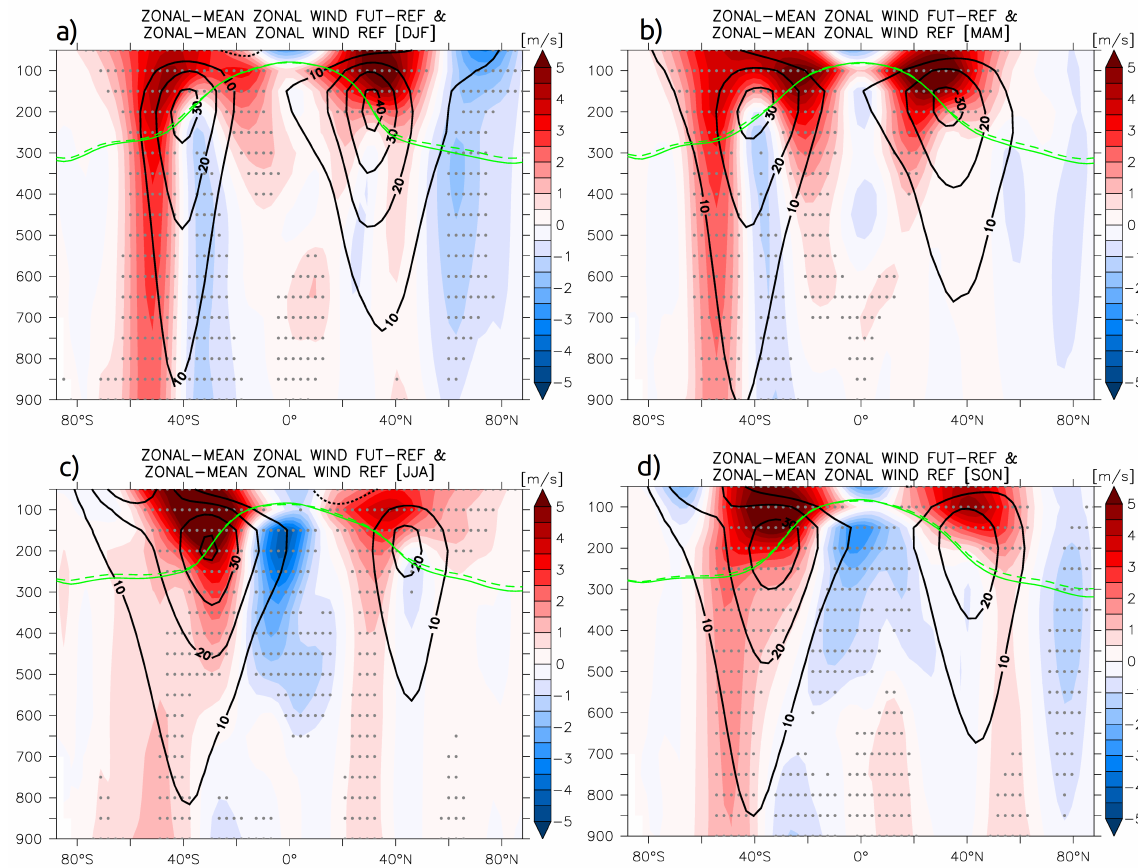
Figure 2. Zonal-mean zonal wind differences (ms − 1 ) between the FUT and REF periods for DJF (a) , MAM (b) , JJA (c) , and SON (d) . The black contours indicate the zonal-mean zonal wind climatology (ms − 1 ) for the REF period. The green solid (dashed) line denotes the height of the tropopause during the REF (FUT) period. Grey dots denote statistically significant changes at the 99% confidence